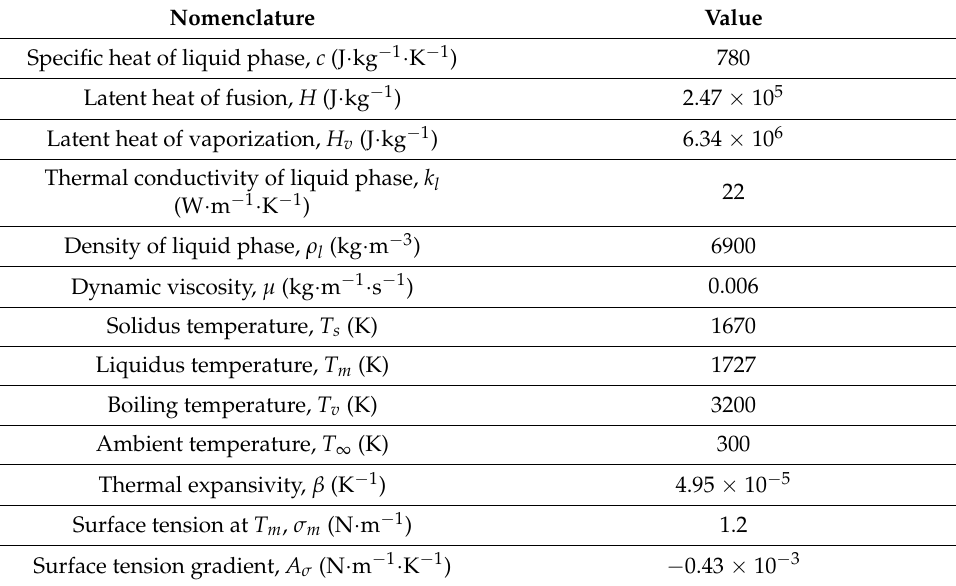
Figure 3. Laser remelting physical mold. Table 1. Physical properties of 304 stainless steel [22,23].